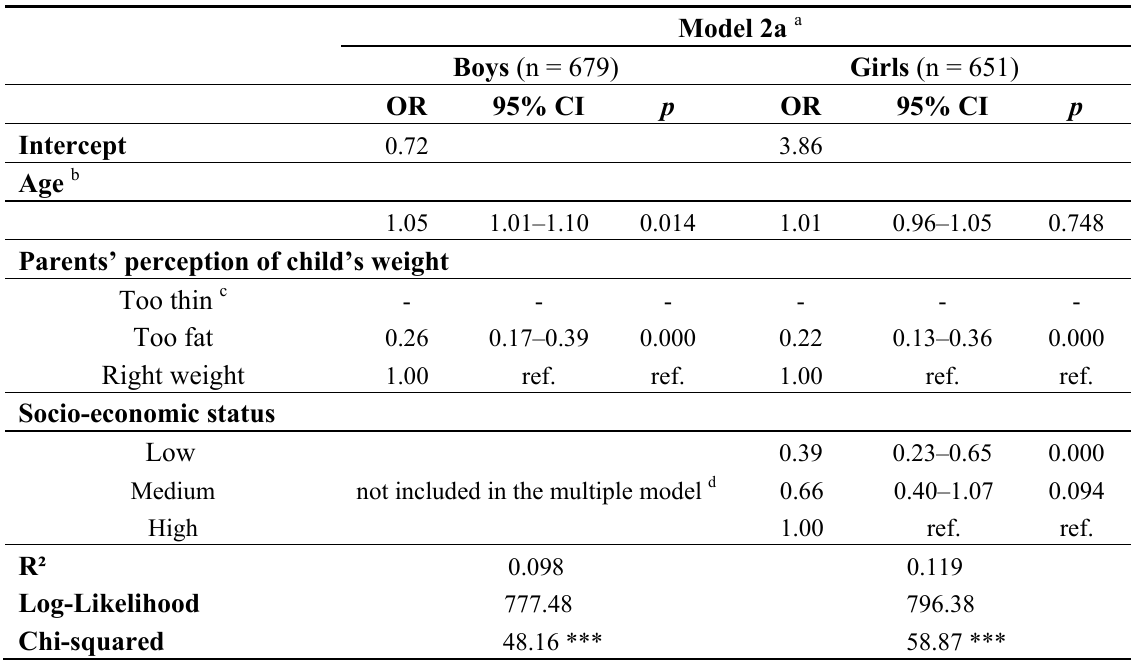
Table 5. Multiple logistic regression models for overweight boys and girls misclassified by parental reports as normal weight or